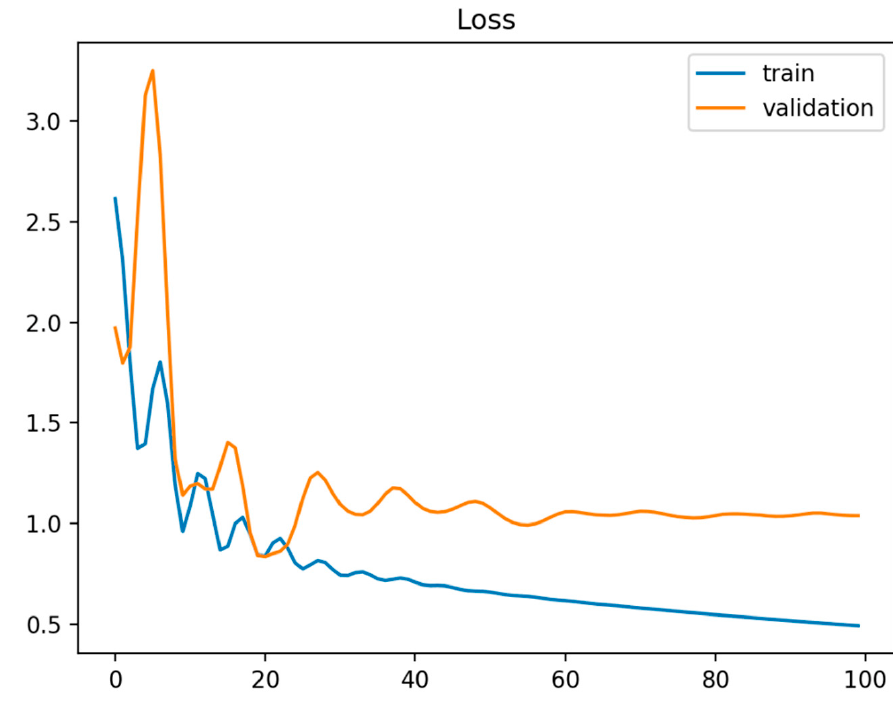
Figure 8. Forecast of testing data—Krishna River plateau dataset.